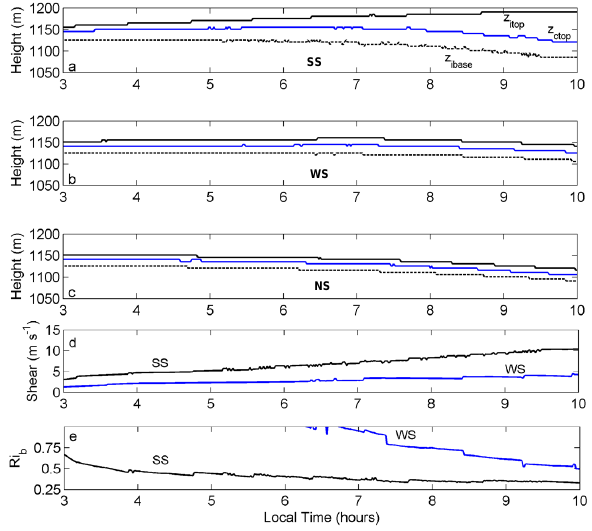
Fig. 6. Temporal evolutions of the inversion layer characteristics. (a) – (c) Evolution of the inversion top z itop (solid black curve), inversion base z ibase (dashed black) and cloud-top heights z ctop (blue lines); (d) the overall wind shear ( ) with black curve for SS and blue for WS; and (e) the bulk Richardson number Ri b with the black for SS and blue for WS. The wind shear from NS is zero and Ri b is ill-defined; they are not presented here.